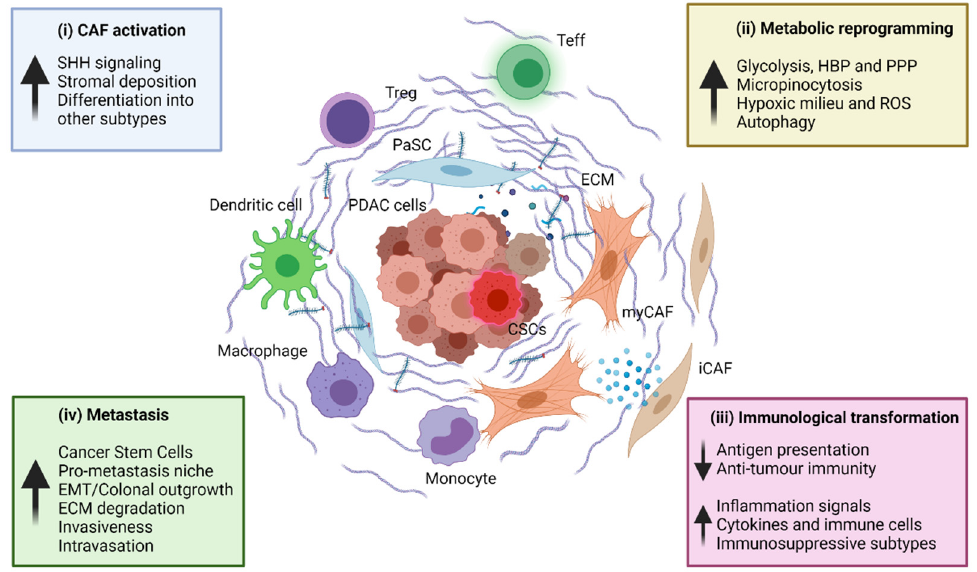
Figure 1. PDAC microenvironment and the cellular interplay. Pancreatic ductal adenocarcinoma (PDAC) is highly heterogeneous in both cellular and acellular components. The tumor cells them- selves are varied in mutation/gene expression profile, which manipulates the surrounding fibroblasts and immune cells. In turn, the tumor microenvironment components interact with each other and with tumor cells in a pro-tumor support fashion. The major interplay in PDAC includes ( i ) CAFs activation which leads to creating a desmoplastic stroma, ( ii ) metabolic reprogramming, ( iii ) immuno- logical transformation, and ( iv ) metastasis initiating events in early stages of tumor development. Treg = regulatory T cell, Teff = effector T cell, PaSC = Pancreatic stellate cells, PDAC = pancreatic ductal adenocarcinoma, EMC = extracellular matrix, myCAF = myofibroplastic cancer associated fibroblast, iCAF = inflammatory cancer associated fibroblast. Figure made in BioRender.